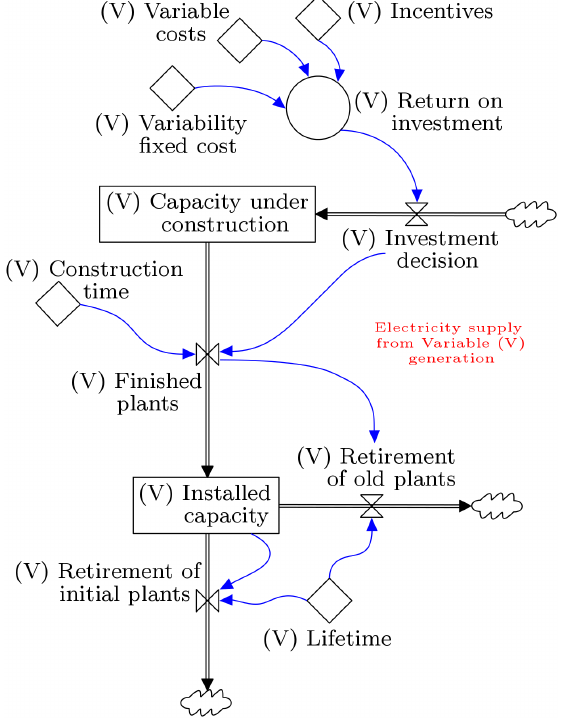
Figure 3. Electricity supply from ( V )